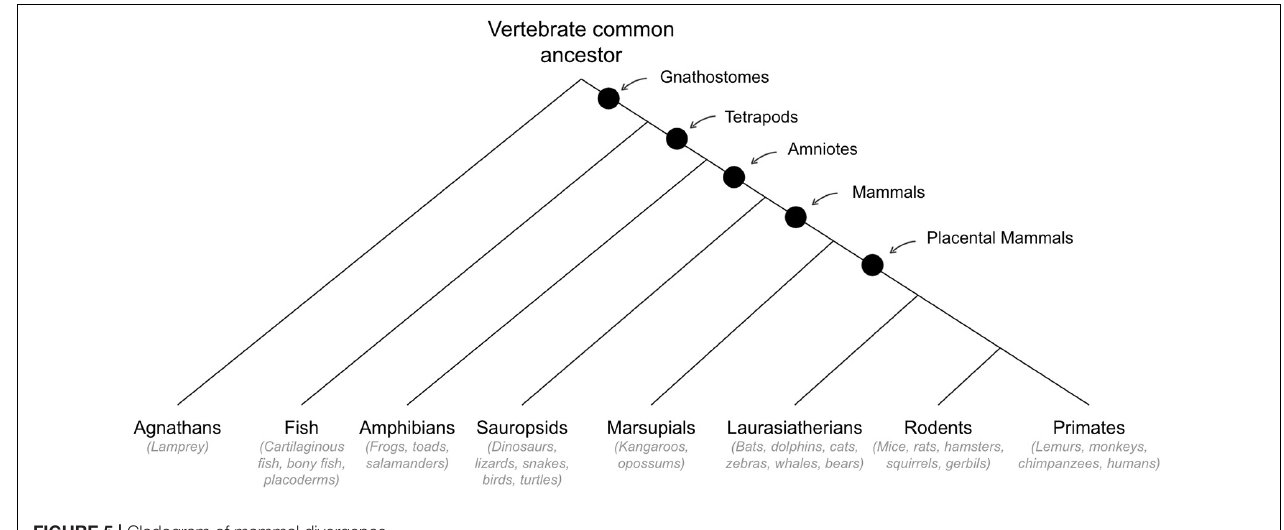
FIGURE 5 | Cladogram of mammal